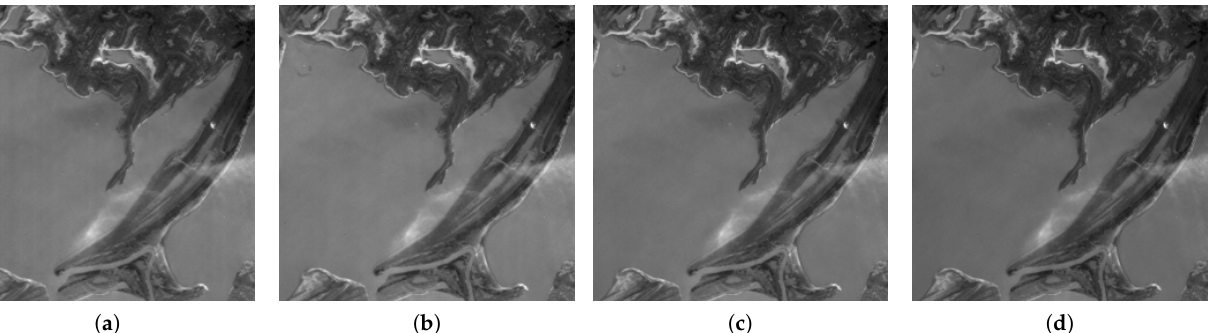
Figure 17. Corrected CHRIS_AM images for band 6. Images corrected by CSCNet composed of ( a ) 1, ( b ) 2, ( c ) 4, and ( d ) 6 MCSCMs.